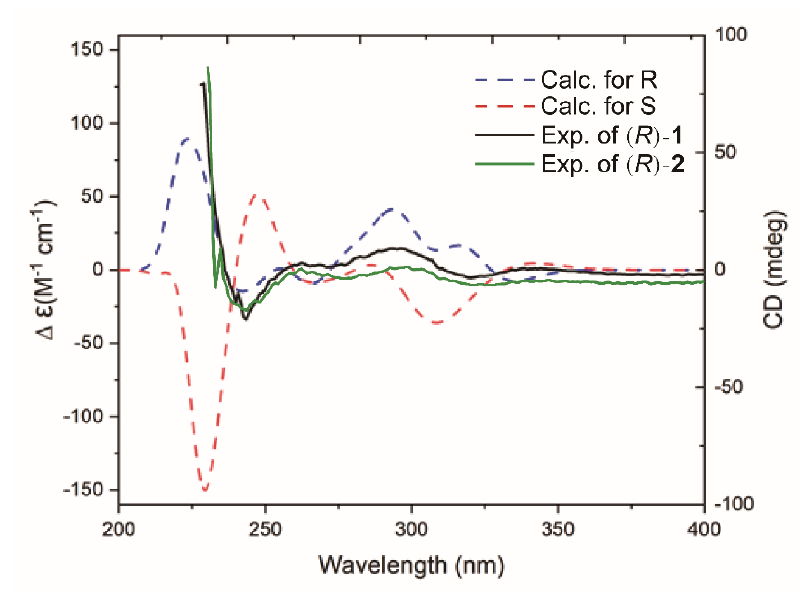
Figure 7. Experimental CD spectrum of 1-2 and simulated CD spectra corresponding to the R (blue curve) and S (red curve) enantiomers of 1-2 as calculated.